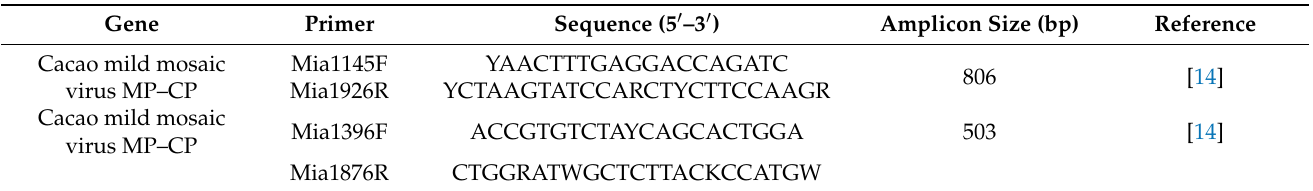
Table 2. Primer pairs designed to amplify the movement protein–coat protein (MP–CP) genome region of CaMMV were used to detect the virus in individual mealybug specimens. Gene Primer Sequence (5 (cid:48) –3 (cid:48)